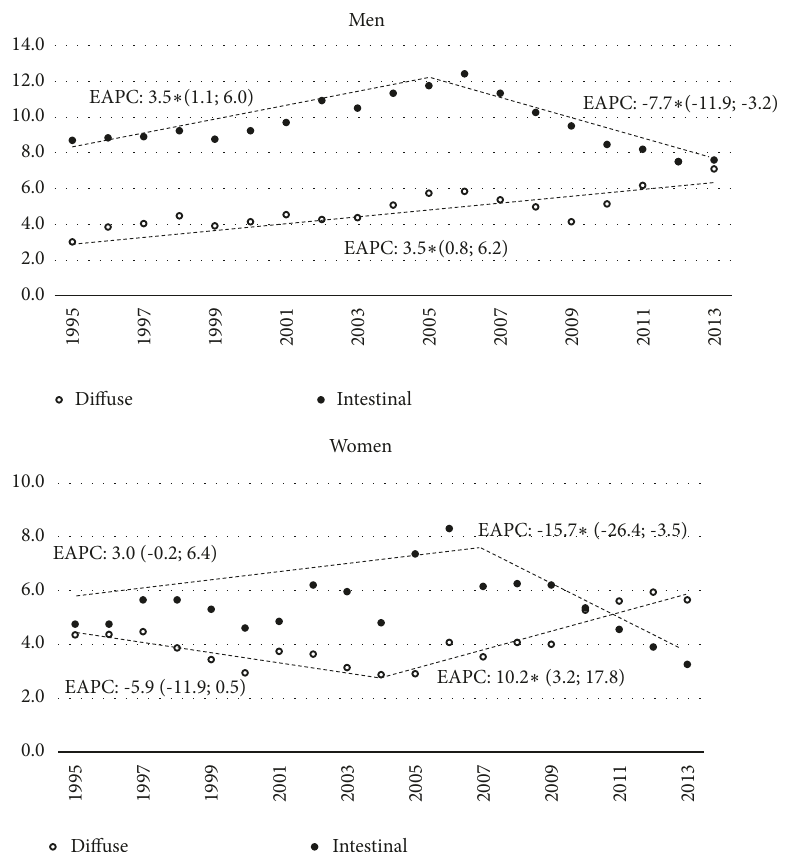
Figure 4: Standardized incidence rate trend for gastric cancer in women and men, by subtype. Includes EAPC based on joinpoint models. EAPC: Estimated Annual Percent Change, figures between brackets are 95% CI of EAPC; a star indicates statistical significance at 𝛼